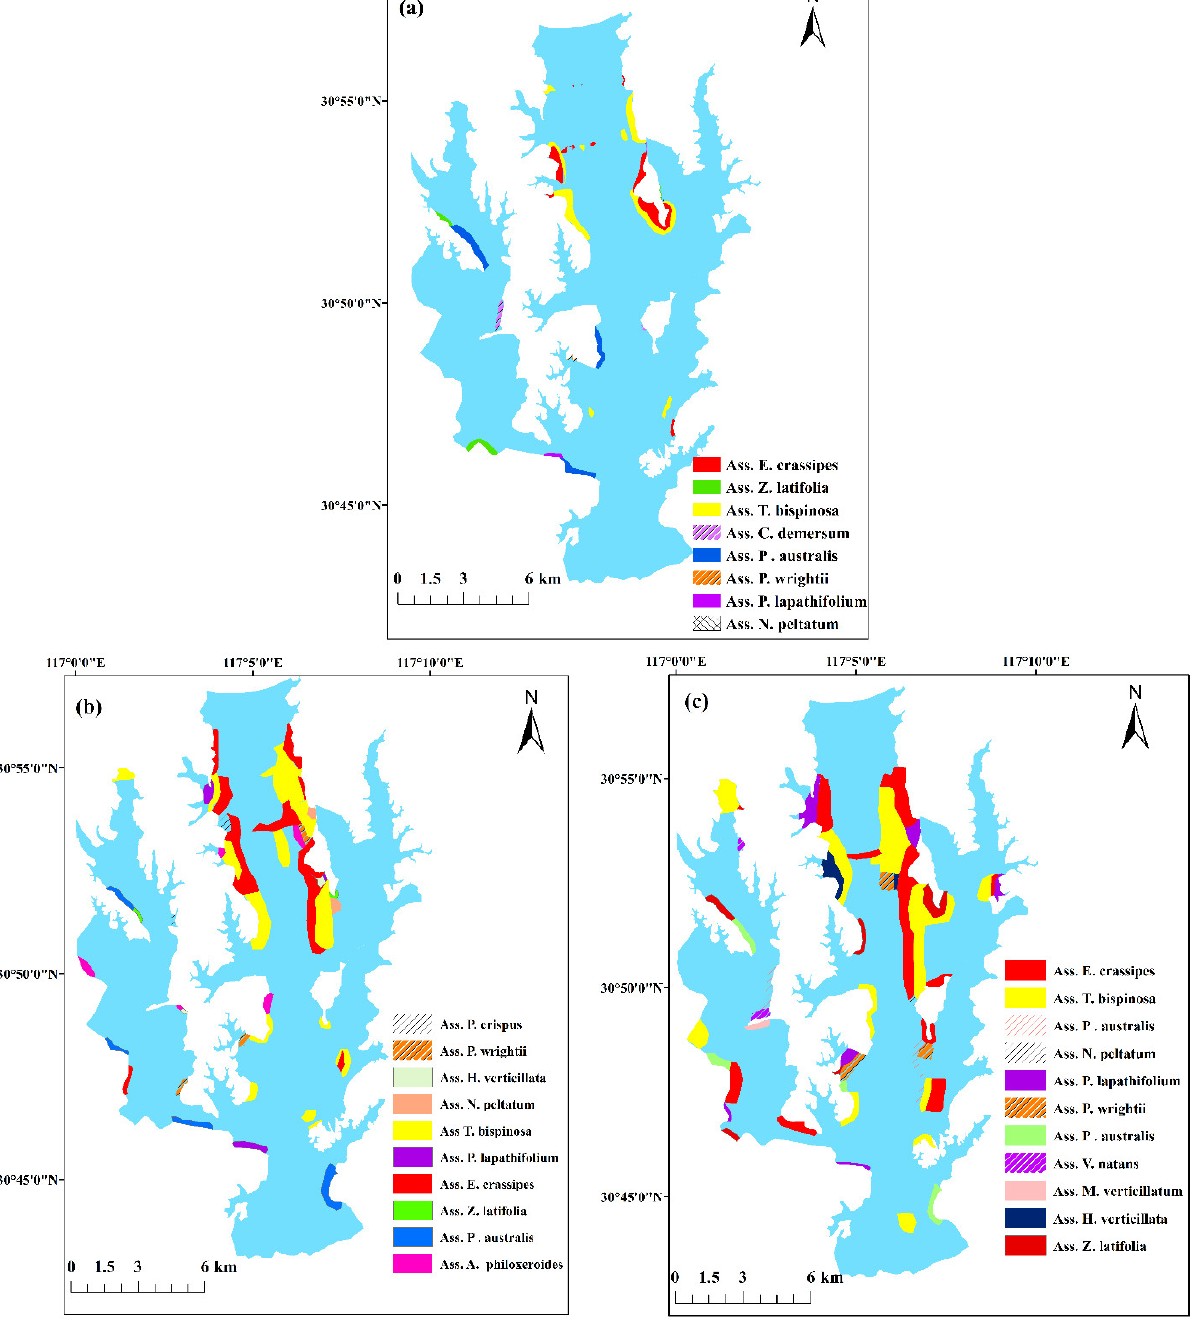
Figure 3. Distribution of aquatic vegetation in Caizi Lakes before and after removal of culture purse seine. Panel ( a ) presented the aquatic vegetation in July 2017 before restoration, and panels ( b ) and ( c ) presented the aquatic vegetation in August 2019 and July 2021 after restoration, respectively.